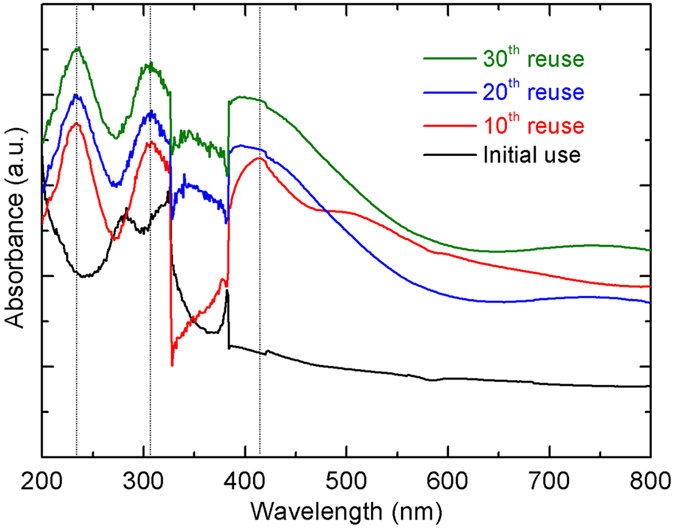
UV-DRS of the fresh and used amorphous Fe78Si9B13 ribbons.